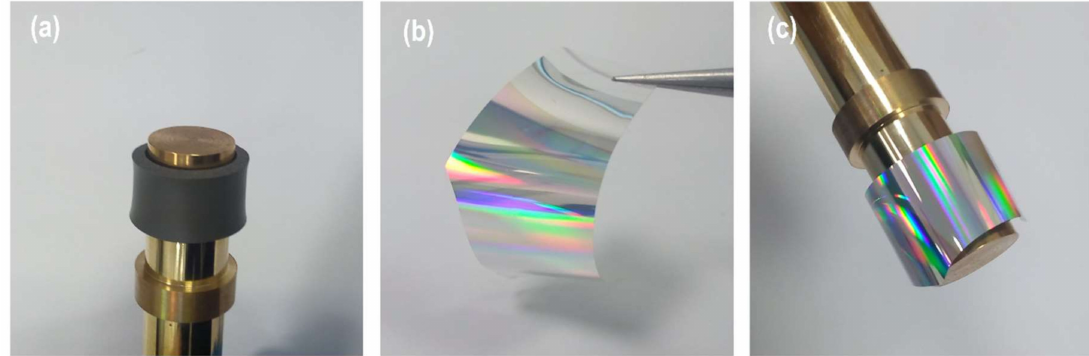
Figure 4. ( a ) roller with a rubber band. ( b ) peeled polycarbonate strip. ( c ) completed roller stamp.